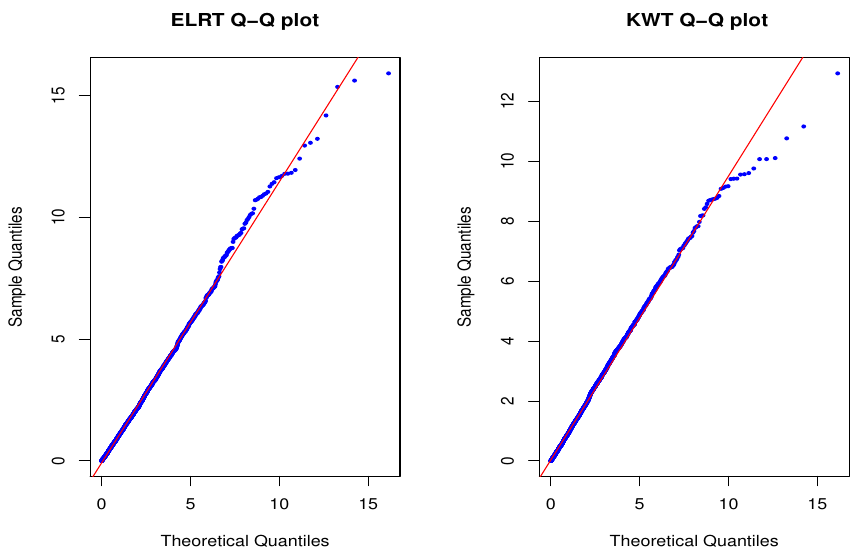
Figure 2. λ 0 = 1, the sample size is (30,30,40), the Q-Q plots of ELRT and KWT for the overall comparison of the 3 Poisson distributions.